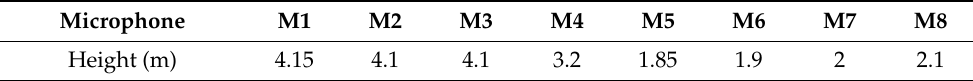
Table 1. Height at which the microphones were set up at the respective position (in meters).